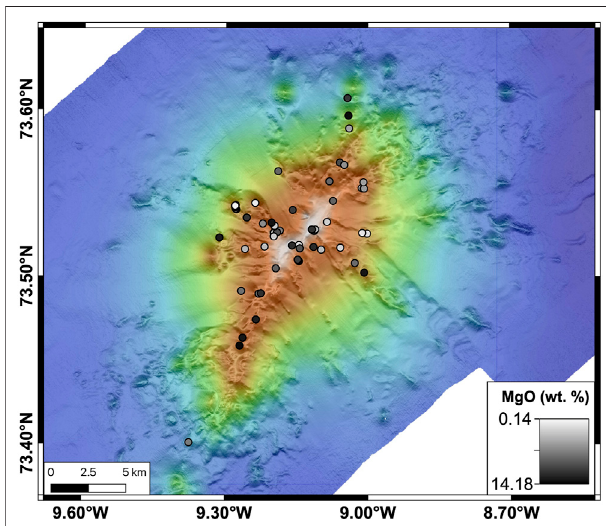
FIGURE 10 | Bathymetric map as in Figure 2 presenting lava sample locations from cruises ARKVII/1 and MSM86. The color code indicates the MgO (wt%) of the samples.